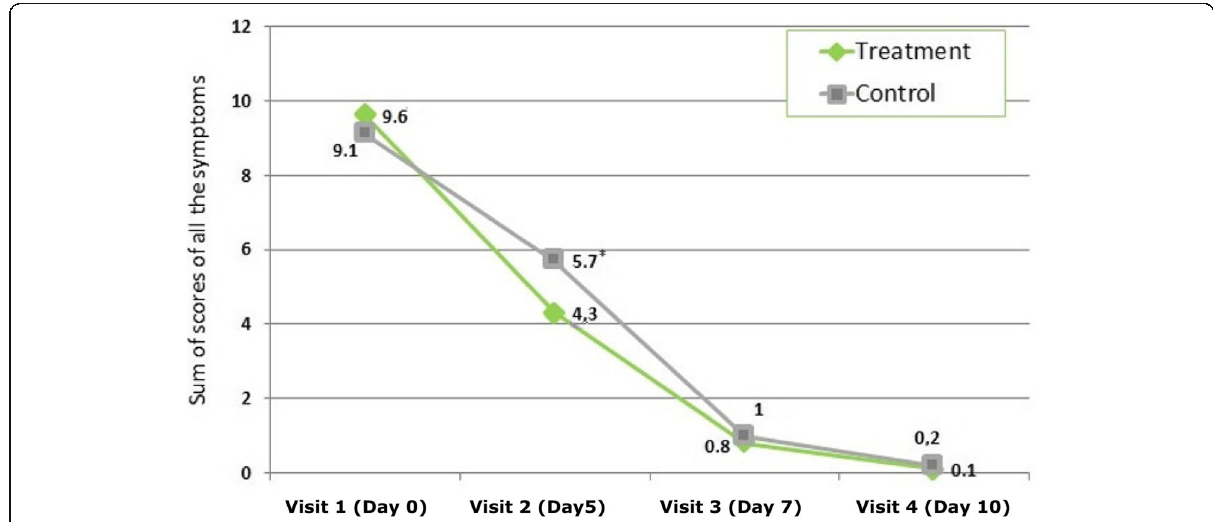
Fig. 4 Physicians ’ assessment of sinusitis severity for all five symptoms (average summary score, of the MSS scale: 0 – 20 points). * p < 0.05: Significant difference between